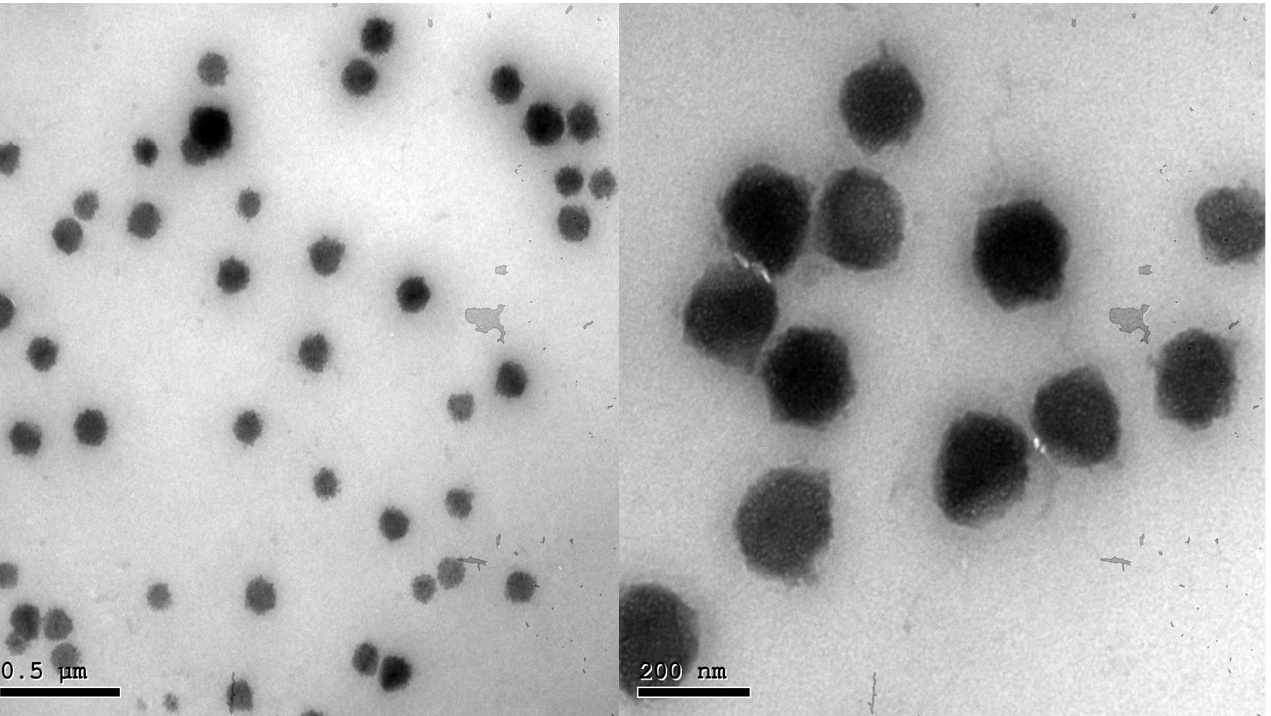
Figure 2. Transmission electron micrograph of the optimized BEO-NPs-SP.